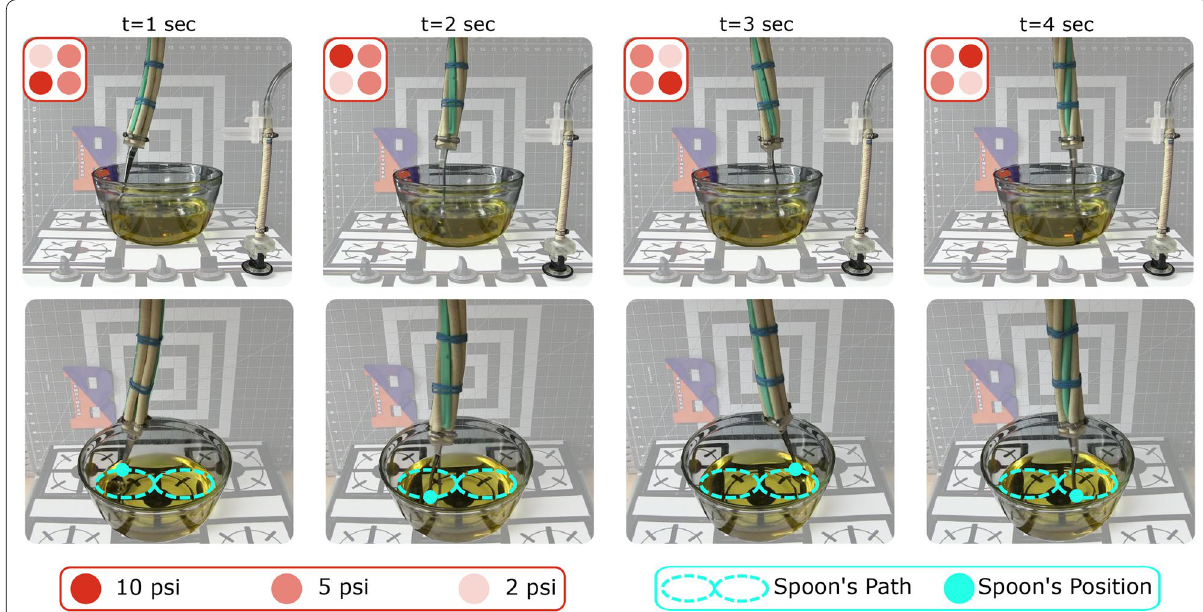
Fig. 11 Cooking demonstration using FREEs. A single 50 ◦ FREE uses our proposed model-based PD controller (see Controller Design) to control the cooking temperature, and a 60 LR module uses a combination of cases 3 and 4 (see Fig. 10) to blend the ingredients of the bowl in a “figure eight” shape (cyan path). See the video of our experiment here: https:// youtu. be/ vwmvW